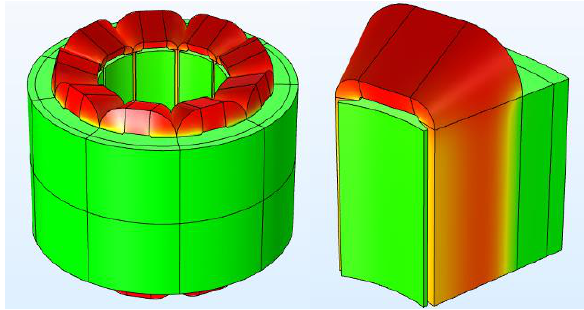
Figure 14. Temperature distribution of the stator and winding in a short time by using COMSOL.